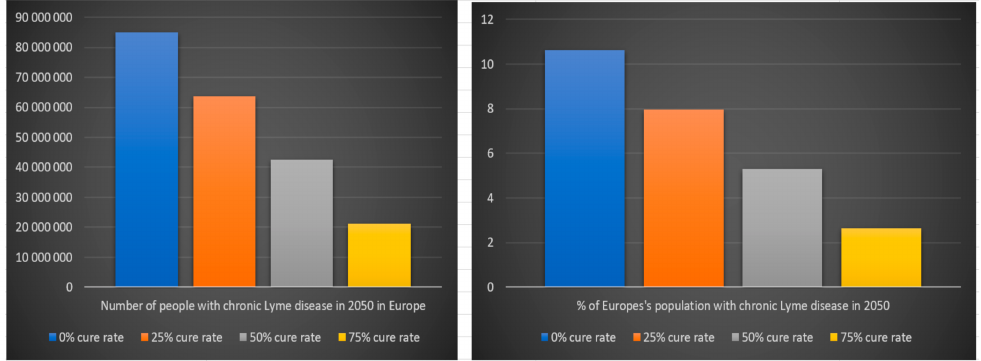
Figure 18. Number of people with chronic Lyme disease in 2050 in Europe.